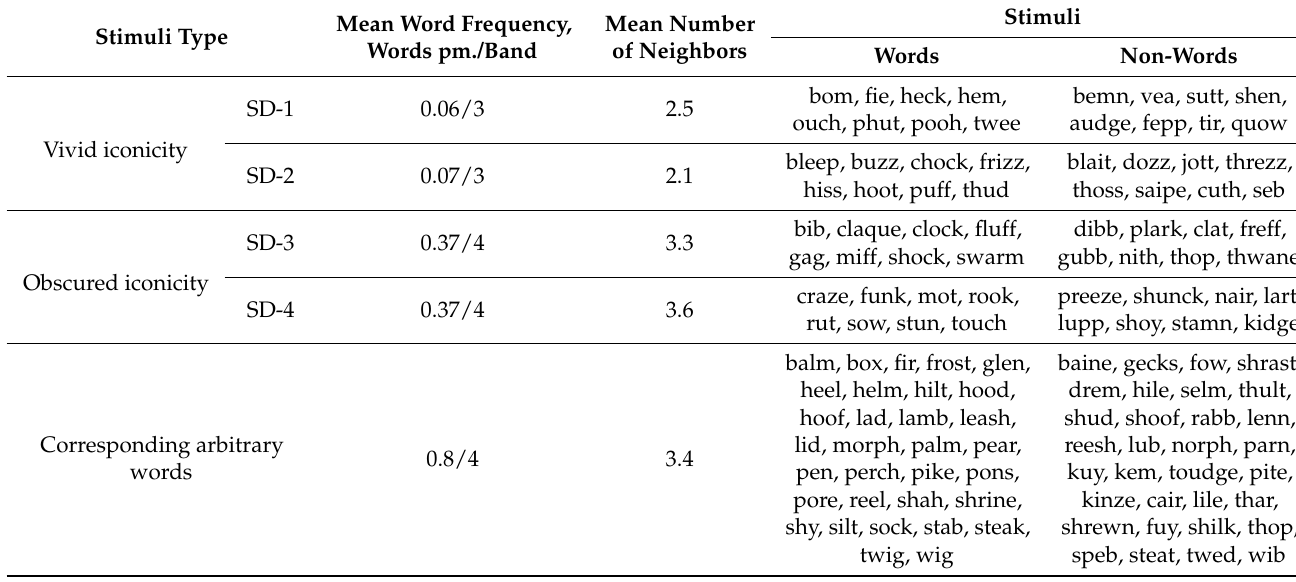
Table 1. English Experimental Stimuli.